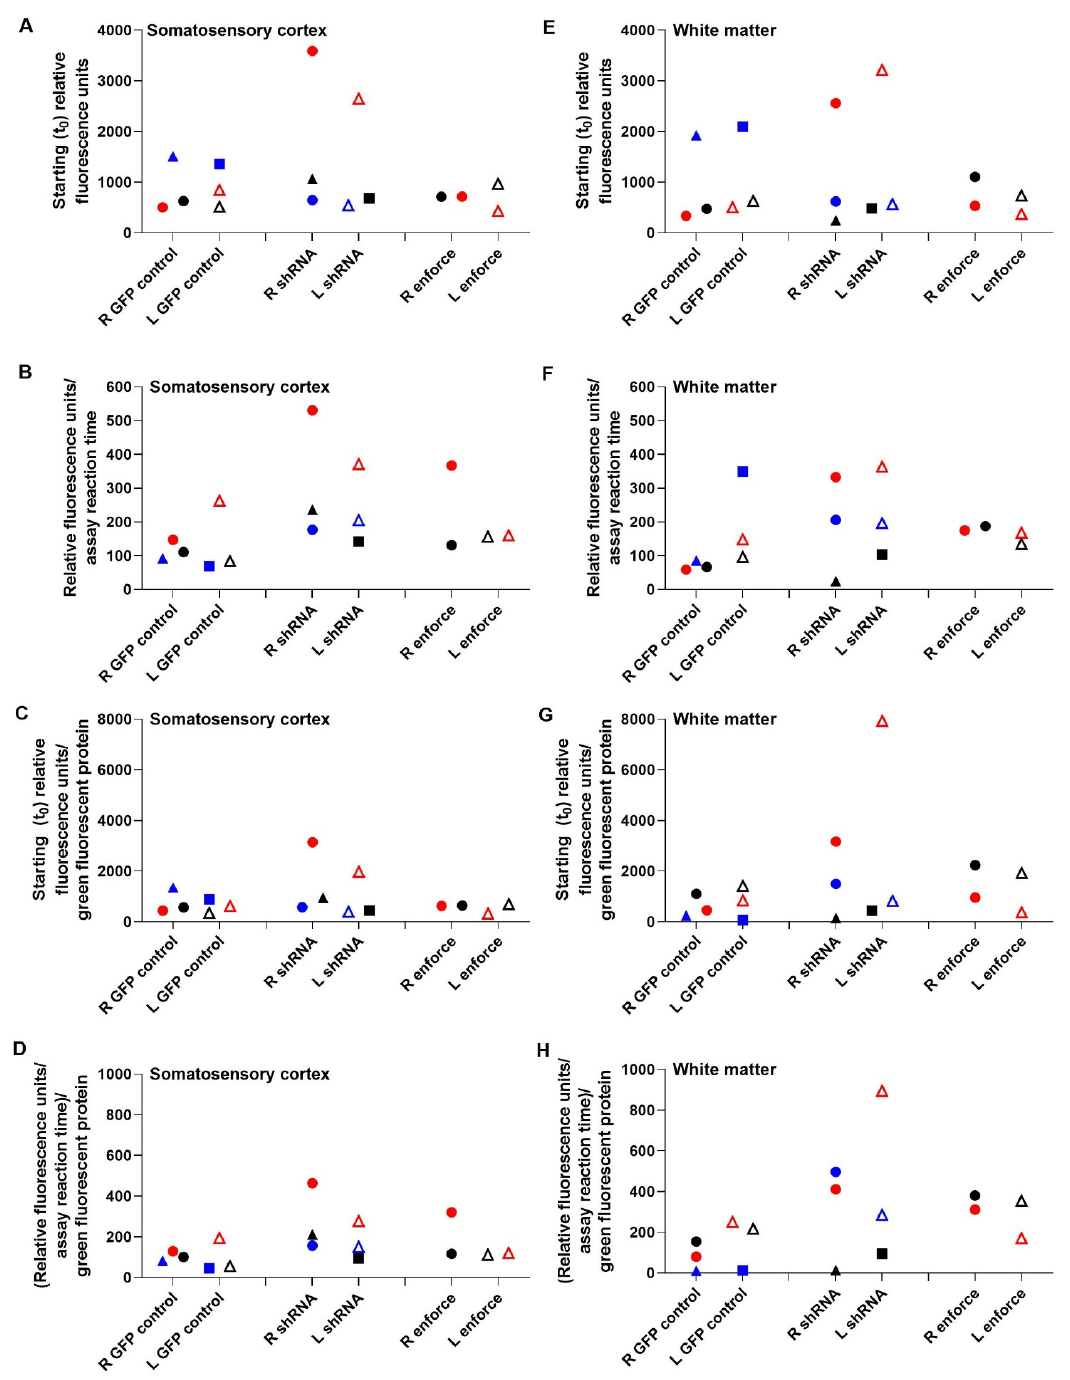
Figure 10. Proteasome activity in piglets that received intracerebral adeno-associated virus (AAV)-green fluorescent protein (GFP), AAV-shRNA to PA28 γ , or AAV-PA28 γ -GFP followed by sham procedure and hypothermia. Starting proteasome activity at t 0 and the slope of proteasome activity over the assay reaction time are shown in the right (R) and left (L) somatosensory cortex ( A – D ) and subcortical white matter ( E – H ). Data in panels ( C , D , G , H ) are normalized to (divided by) the GFP immunoreactivity level from the piglet’s western blot as an indicator of virus transduction. The AAV-shRNA to PA28 γ -GFP did not knock down proteasome activity, and AAV-PA28 γ -GFP did not increase proteasome activity relative to AAV-GFP. Some piglets that received AAV-PA28 γ shRNA-GFP had paradoxical increases in proteasome activity. R- and L-sided data from the same piglet are matched by color within each treatment group. The shapes of the data points indicate the cerebral hemispheric AAV dose: square = 2 × 10 10 –2 × 10 11 genome copies (gc), circle = 4 × 10 10 –4 × 10 11 gc, and triangle = 5 × 10 10 –5 × 10 11 gc. Piglets represented by an open symbol also received 40 ng of F108 and 2.5 µ g of